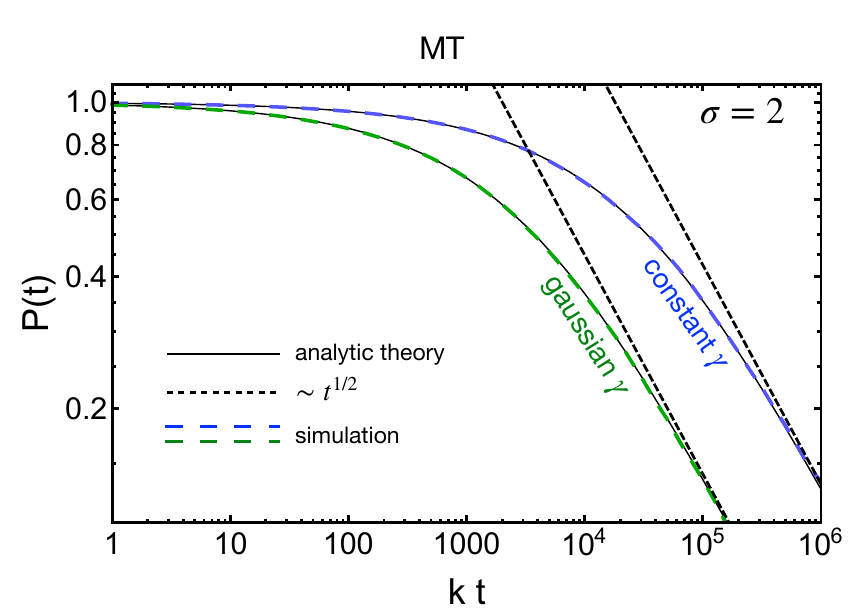
Figure 8. (Color online) Polarization functions in the MT model with the disorder parameter, σ = 2 (exponential density of states), for two different models of the local fields, γ : constant magnitudes (blue) and Gaussian magnitudes (green). The black curves are the analytic theory expressions coming from Equations (14) and (20). The dotted lines are the expression Equation (22). Additional parameters used in simulations are γ = 0.025 (for the Gaussian approximation, γ is the width of the distribution) and k = 1000. The simulations are averaged over 60 k disorder configurations.